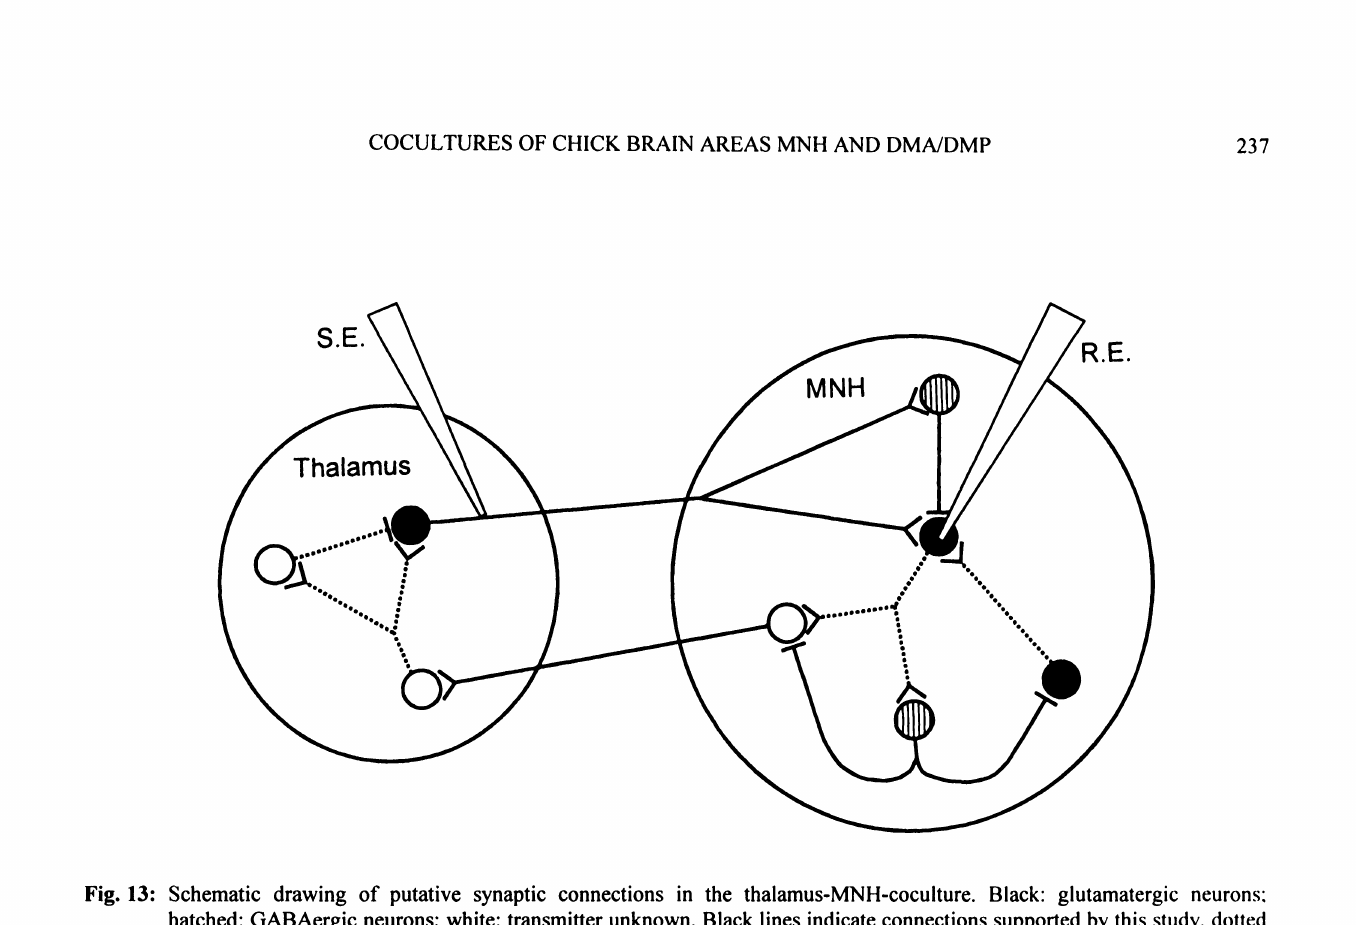
Fig. 13" Schematic drawing of putative synaptic connections in the thalamus-MNH-coculture. Black: glutamatergic neurons: hatched: GABAergic neurons; white: transmitter unknown. Black lines indicate connections supported by this study, dotted lines indicate hypothetical projections. S.E." stimulation electrode; R.E.: recording